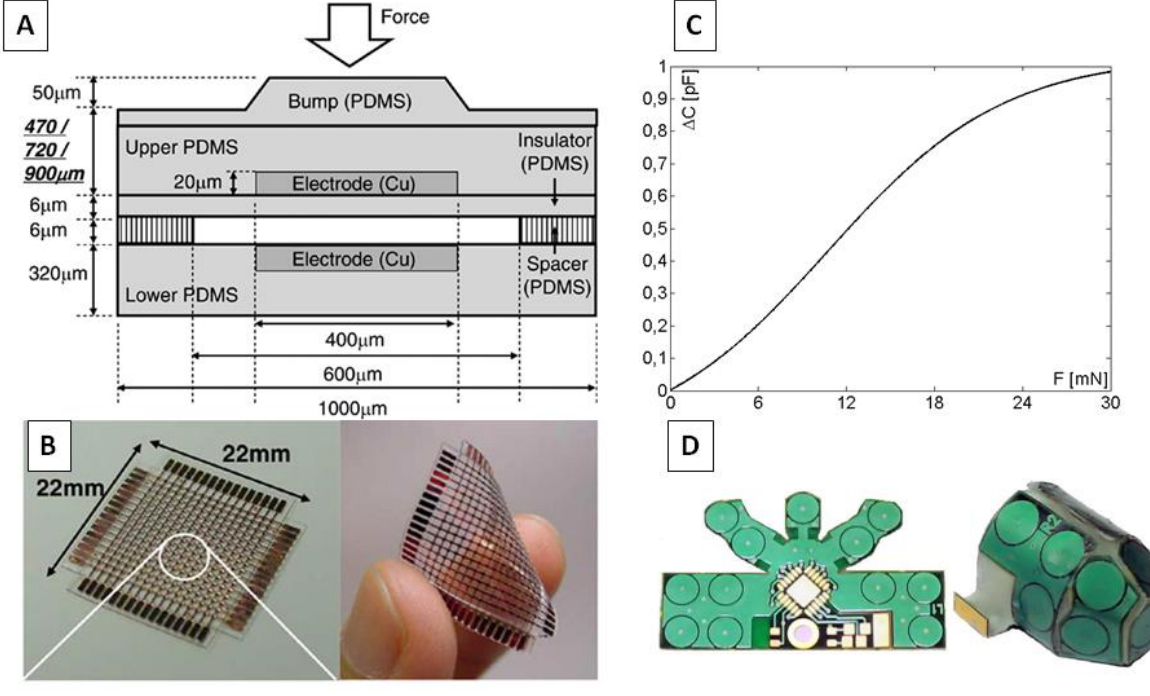
Figure 2. Capacitive sensors used for prosthetic and robotic hands: ( A ) and ( B ) Capacitive tactile sensor consisting of 16 × 16 tactile cells and using polydimethylsiloxsane (PDMS) elastomer [71]; ( C ) typical relationship between change of capacitance and applied force in bio-inspired MEMS sensor; ( D ) Flexible pressure sensor system designed for the fingertips of the humanoid robot iCub